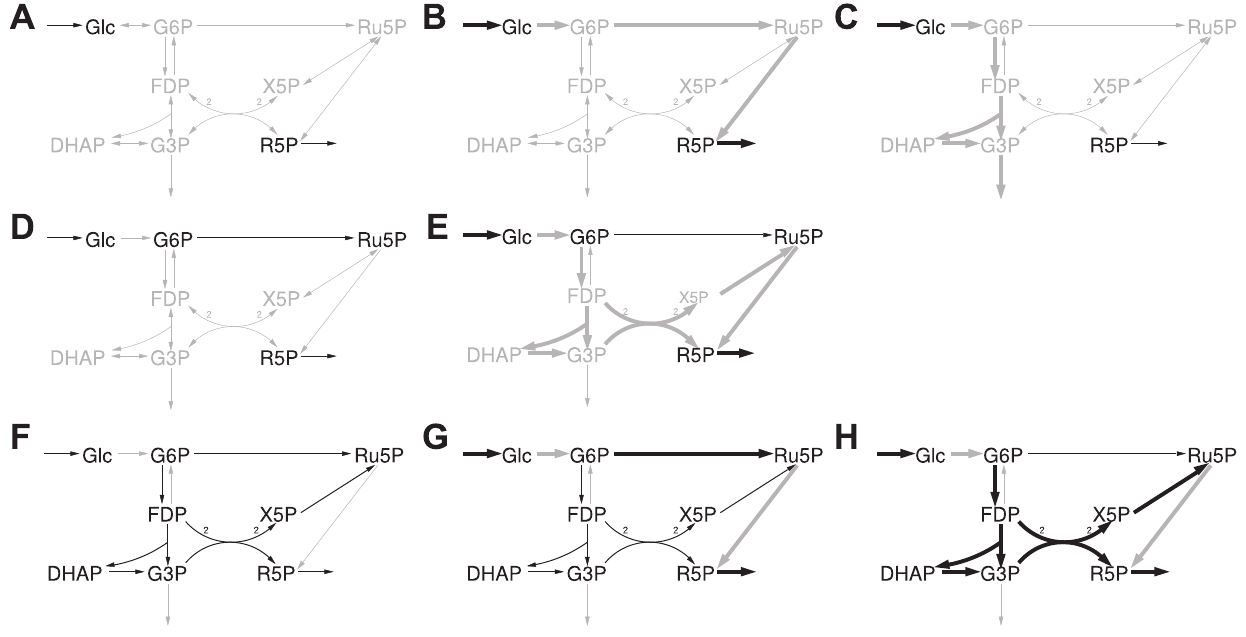
Figure 8. Schematic representation of the iteration process for searching pathways. Black arrows correspond to reactions belonging to the subsystems. A , D and F Subsystems used in the different iteration steps. B , C and E Selected elementary flux patterns (thick black arrows) and the reactions used by an associated elementary mode in the remaining system (thick gray arrows). If only one direction of a reversible reaction belongs to a subsystem, the reverse direction is omitted for clarity. G and H Elementary flux patterns of the final system producing R5P with the associated pathways through the entire system. A list of abbreviations can be found in Table S1.